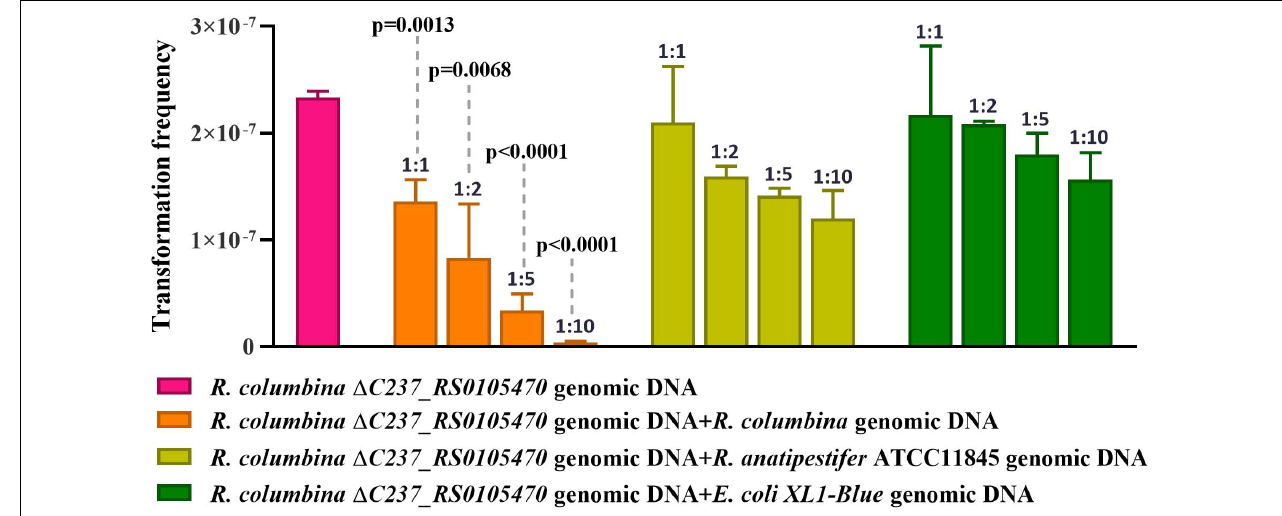
FIGURE 4 | Natural transformation competition experiments. R. columbina was cultured to the logarithmic phase (3–4), and the OD 600 value was determined. The cell culture was adjusted to an OD 600 of 1. A 300 µ l cell culture was transformed with 1 µ g the genome of R. columbina (cid:49) C237_RS0105470 (control) or 1 µ g of donor DNA mixed with different quantity of competing genomic DNA of R. columbina , R. anatipestifer ATCC11845 or E. coli XL1-Blue and incubated at 37 ◦ C for 1 h. The natural TF was calculated as transformants divided by viable bacteria. The P -value refers to the difference between the no-competition and competition measurement, respectively. Insignificance p -value ( P > 0.05) was not shown. All the results are representative of three independent experiments. Error bars denote standard